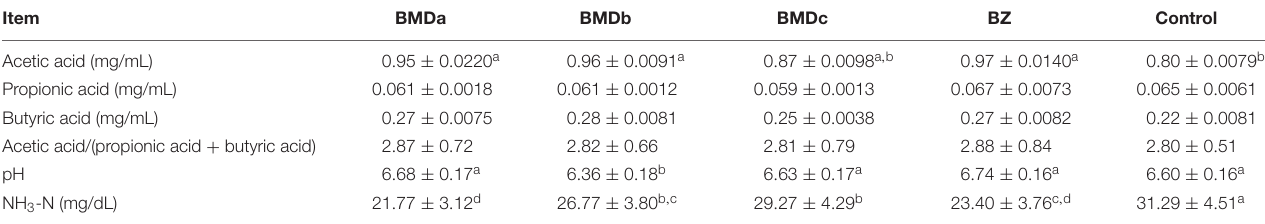
TABLE 2 | Comparison of BMD based on cecal fermentation in weaned rabbits.